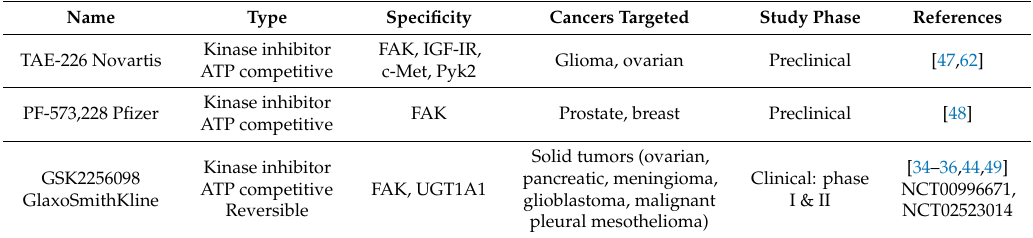
Figure 1. The domain organization and activation of focal adhesion kinase (FAK). FAK is composed of a central kinase domain (KD), an amino-terminal side that is flanked by a protein band 4.1-ezrin-radixin- moesin (FERM) homology domain, and a carboxy-terminal focal adhesion targeting (FAT) domain flanked by proline-rich regions (PRRs). FAK localizes to focal adhesions and is triggered off by extracellular signals such as integrin-mediated adhesion and some growth factors. FAK is maintained in an inactive state by the binding of the FERM domain to the kinase domain, which blocks access to the catalytic site and sequesters the activation loop, as well as the key autophosphorylation site tyrosine 397 (Tyr397). Engagement of integrins with the extracellular matrix (ECM) or growth factors leads to signals that displace the FERM domain, resulting in rapid autophosphorylation of Tyr397, which is a critical event in signal transduction by FAK. Table 1. FAK inhibitors with anti-tumor activity in preclinical studies and clinical trials.